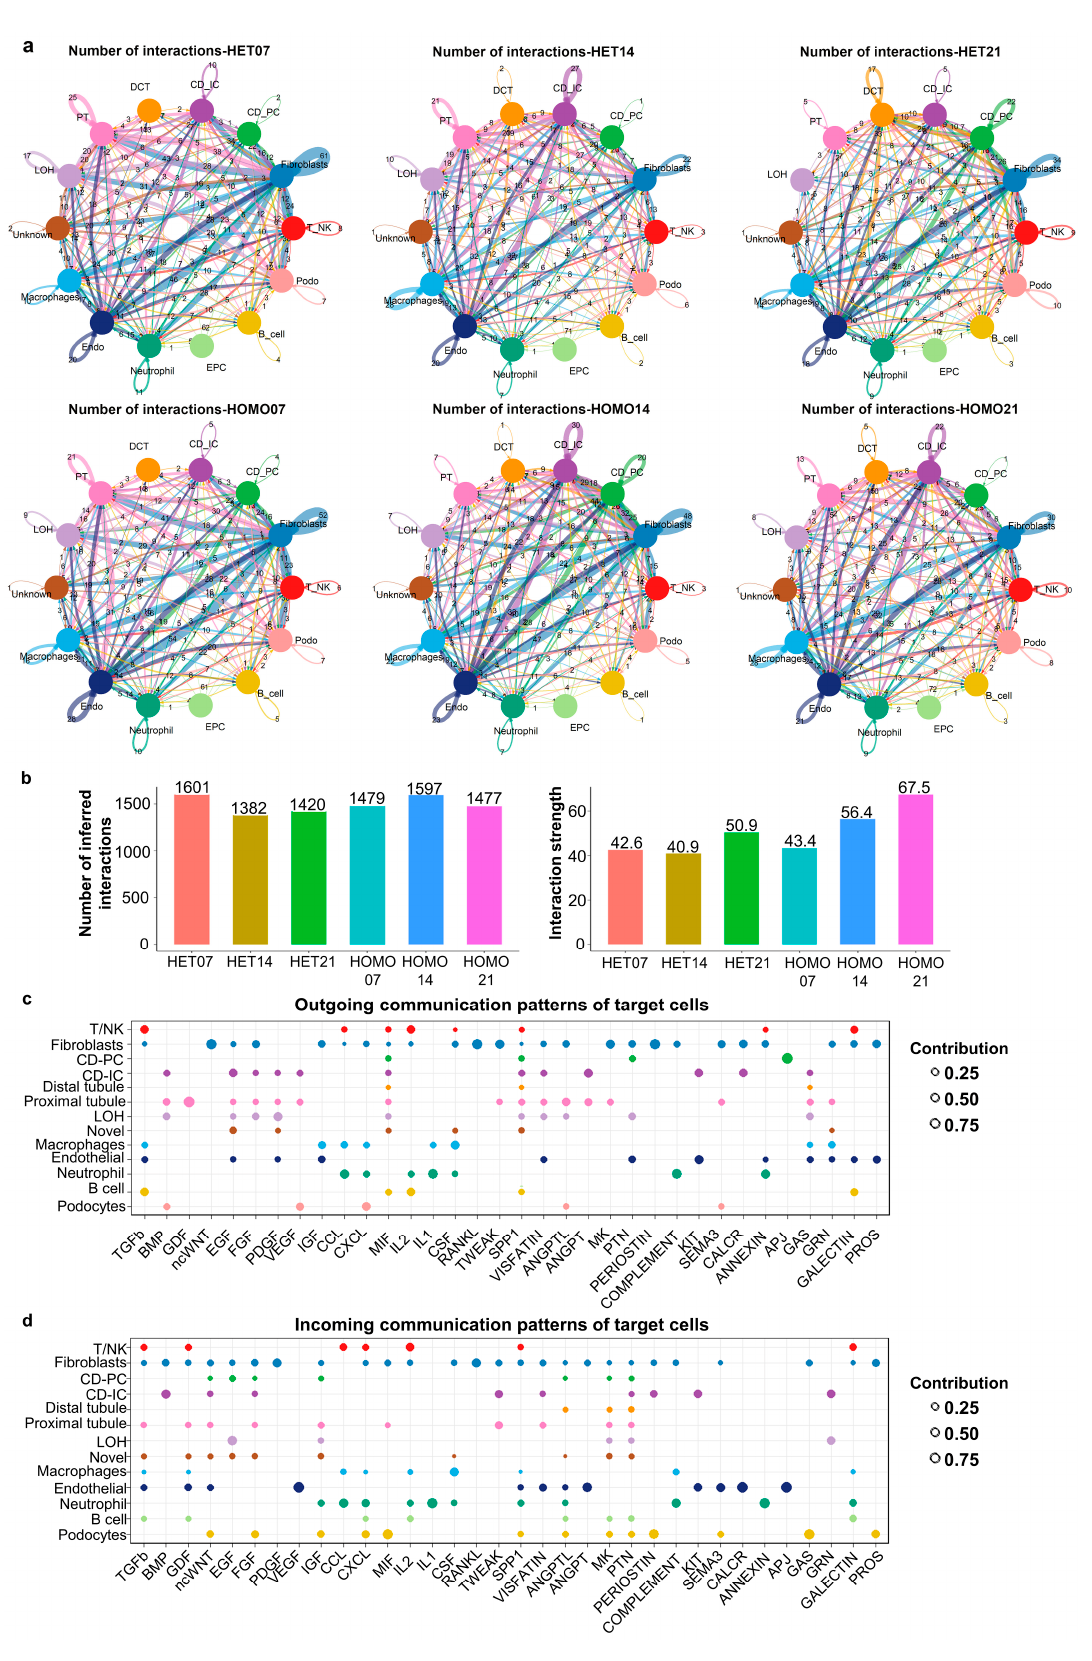
Figure 6. Global analysis of cell-to-cell communications in Pkd1 heterozygous and homozygous kidneys. ( a ) Circle plots showing the numbers and strengths of interactions in each kidney